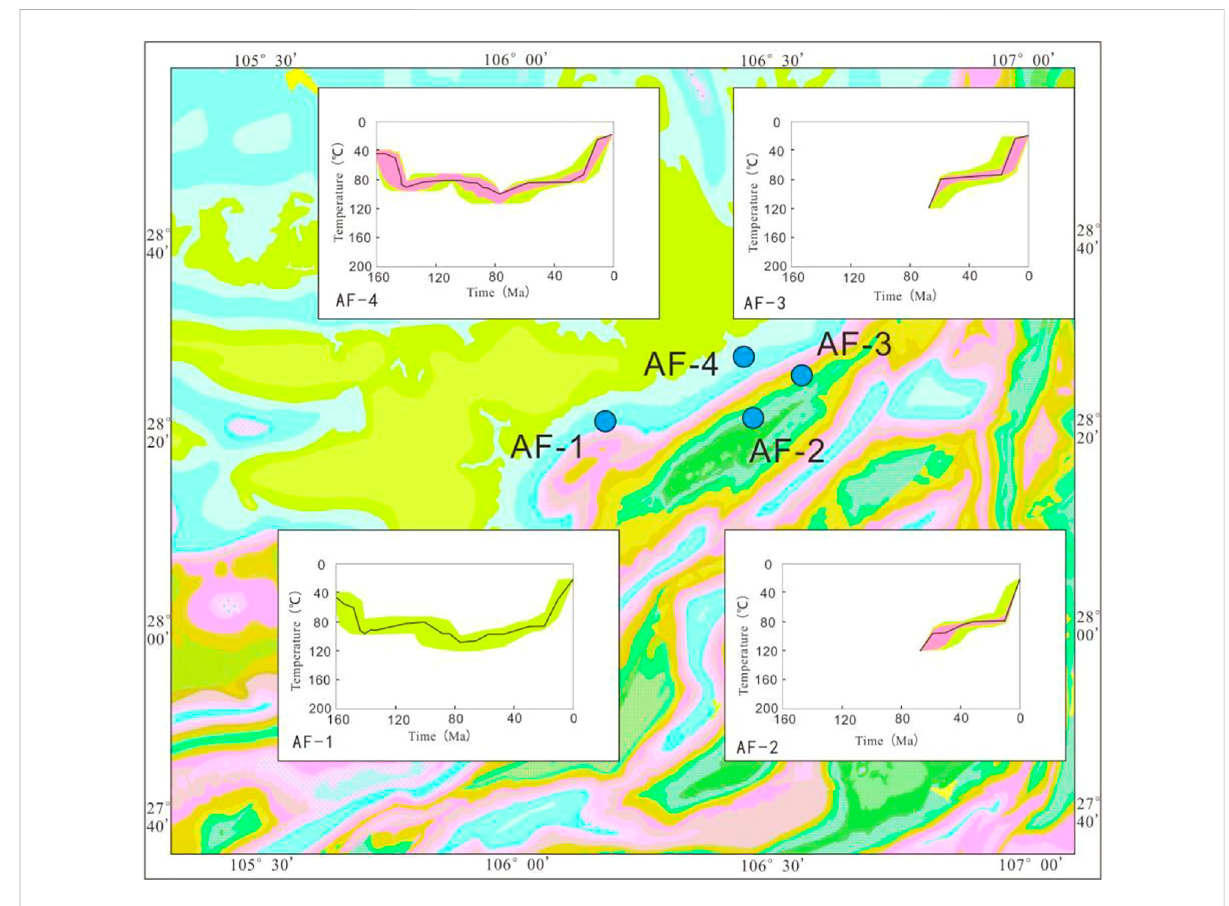
FIGURE 7 Thermal history simulation of apatite fi ssion tracks in Lintanchang area (according to Deng et al., 2013).